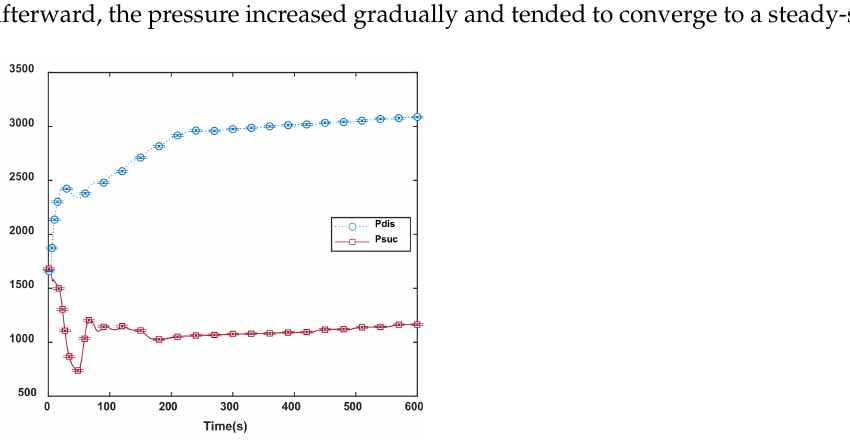
Figure 3. Variation in compressor suction and discharge pressure with rated refrigerant charge.